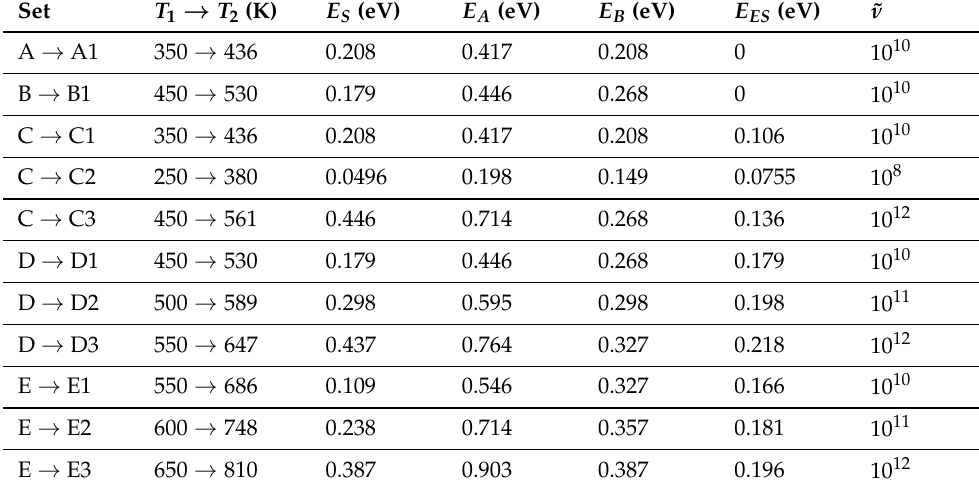
Table 1. Sets of activation energies and temperatures used in the simulations. Observe that deposition is simulated at constant temperature, T 1 or T 2 , not at varying